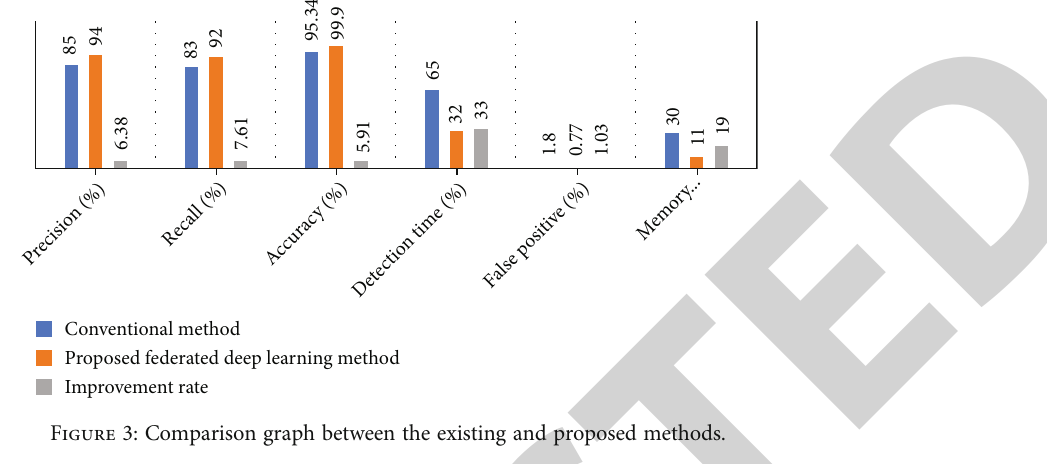
Figure 4: Comparison graph.